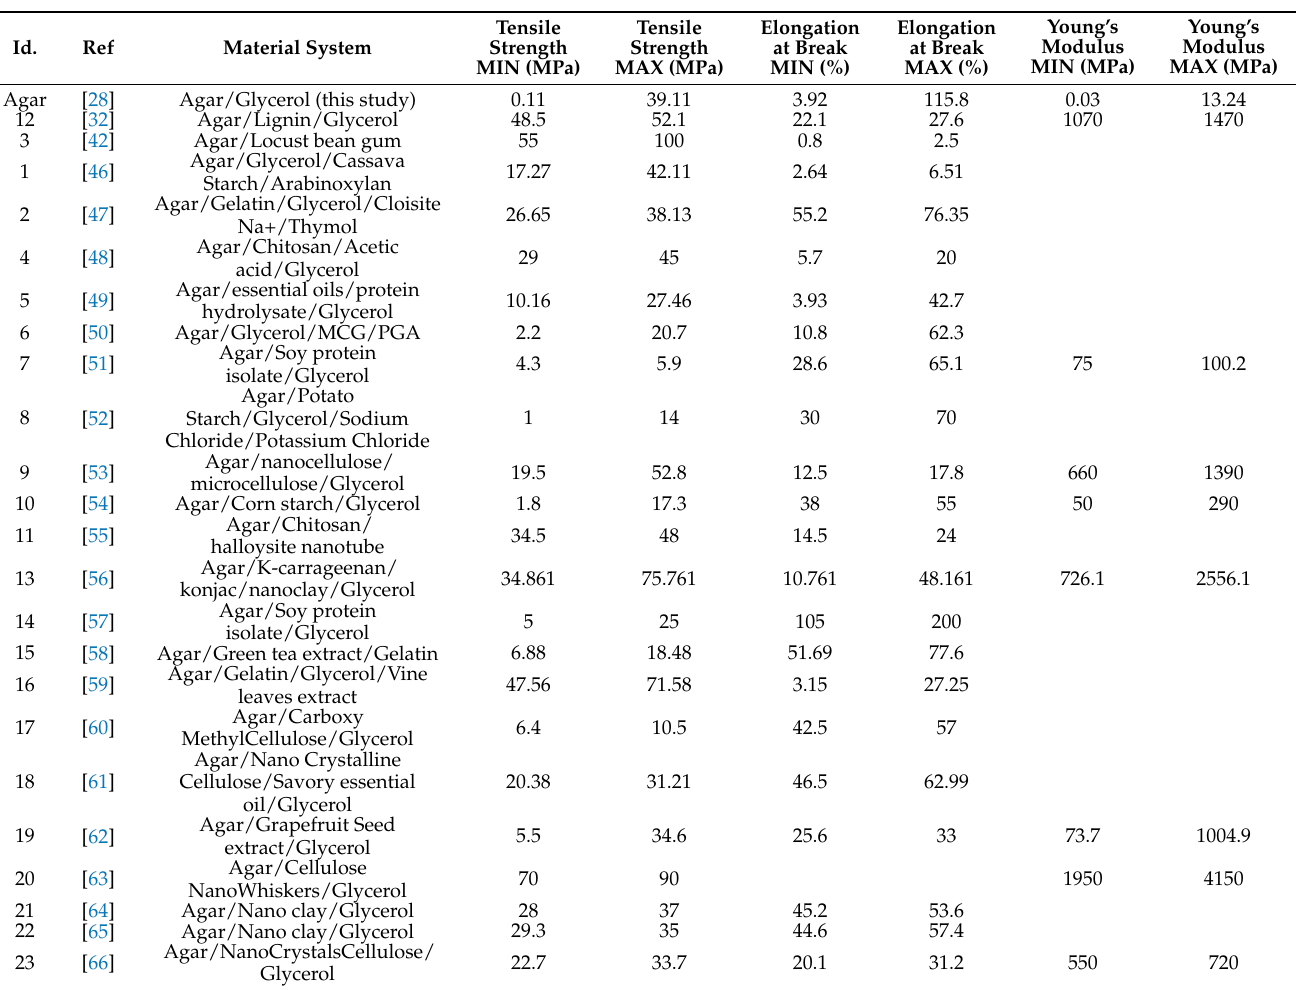
Table A1. Range of mechanical properties of agar-based biopolymer films for food packaging applications.